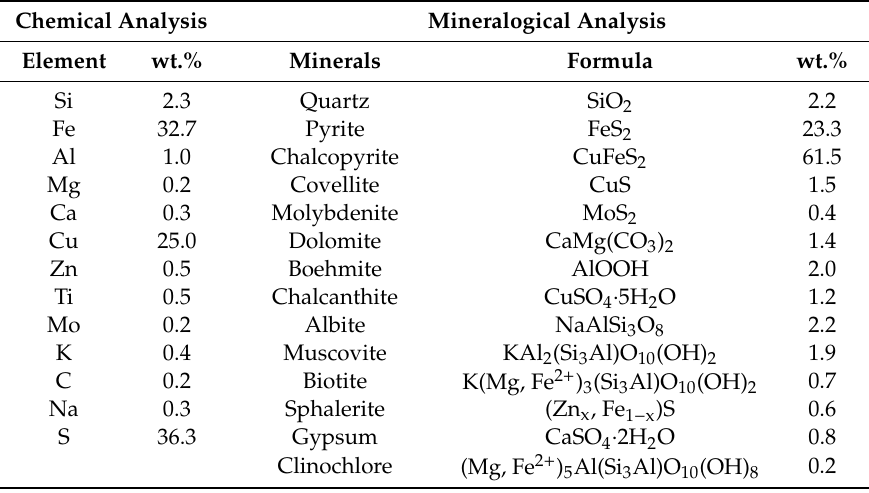
Table 3. Chemical and mineralogical analysis of the chalcopyrite